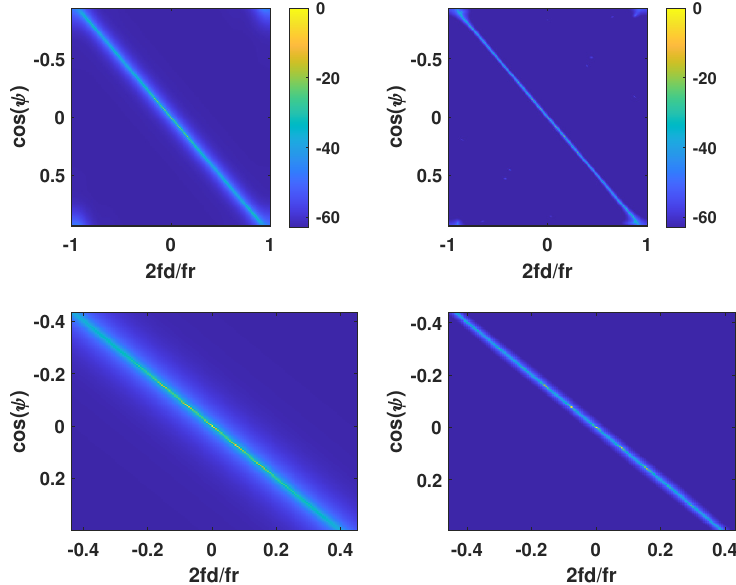
Figure 1. Space-time distributions of clutter spectra with data of original STAP ( left ) and proposed method ( right